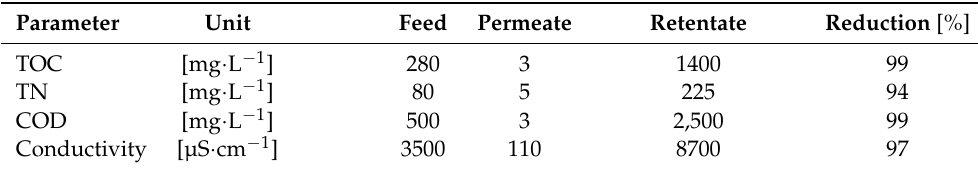
Figure 11. Energy dispersive radiography spectroscopy of sheet membrane BW30 before and after experiment. Table 6. Rejection of the examined parameters by means of BW30 flat sheet membrane at 80%